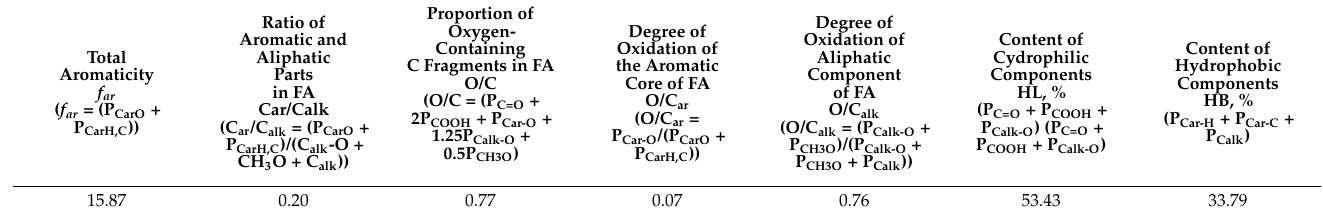
Table 2. Indicators of the structural features of studied FA.